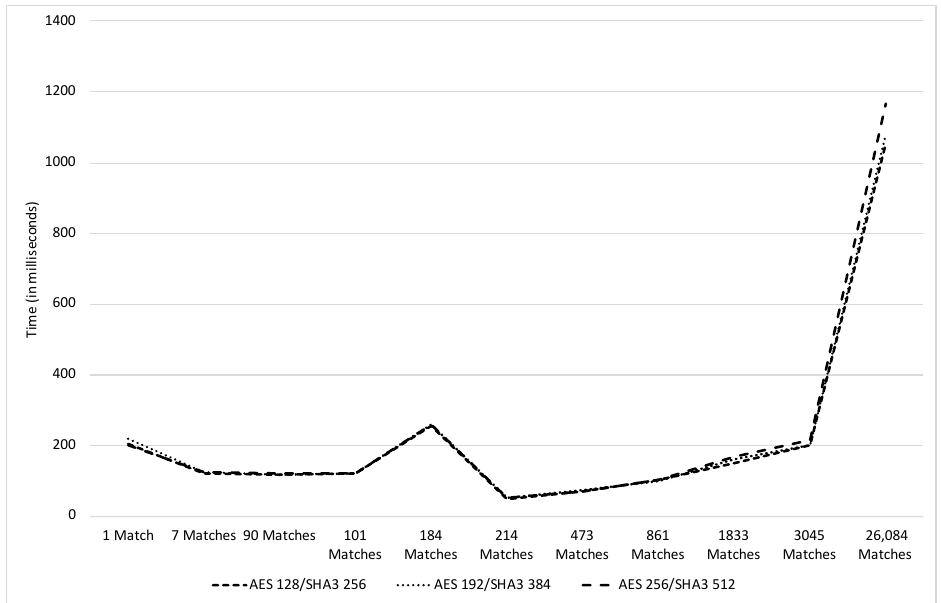
Figure 6. Searching times per key size and